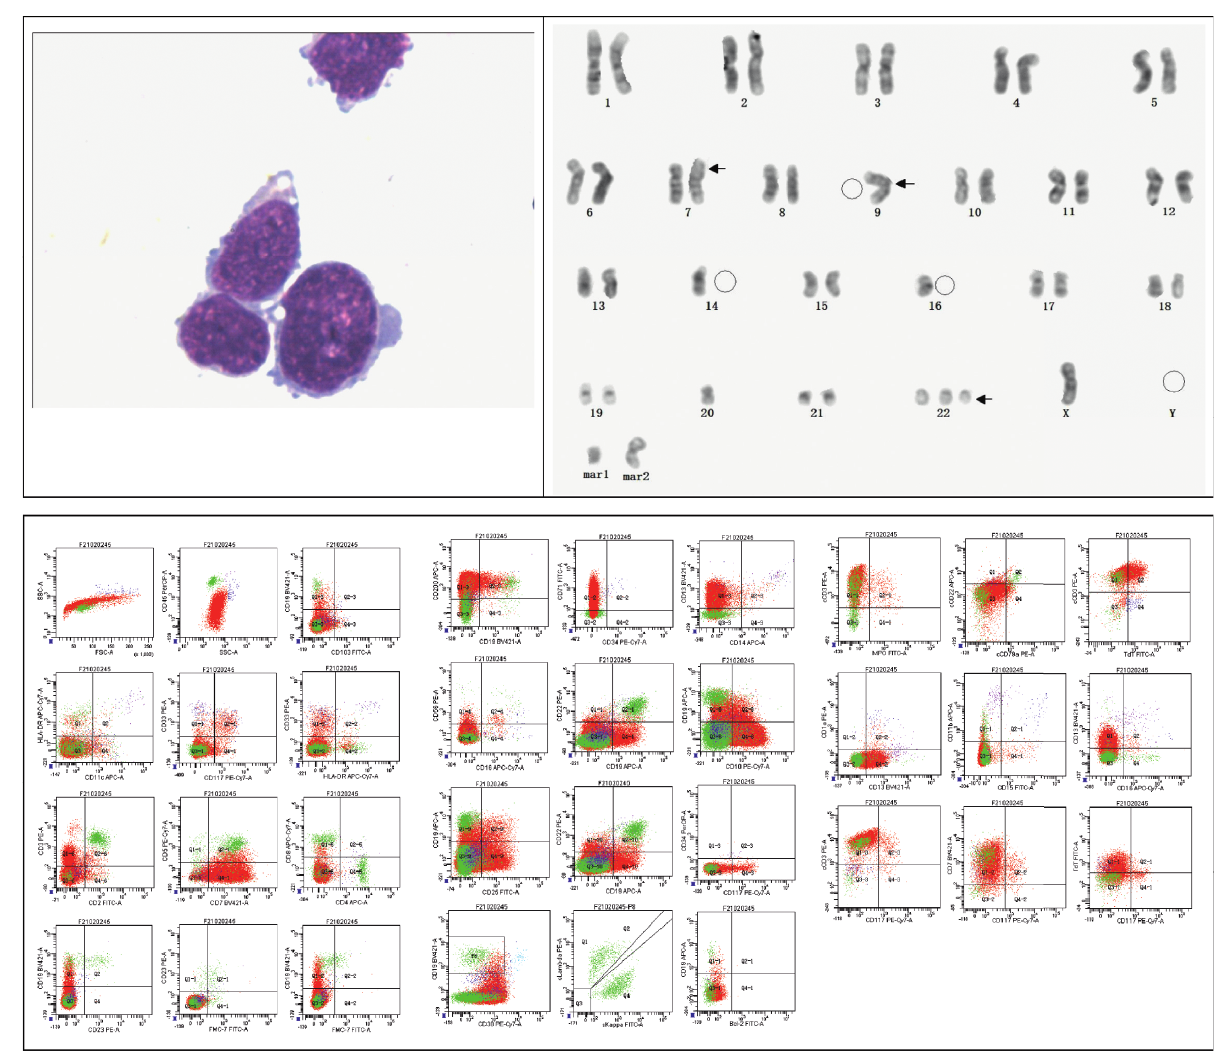
Figure 3: Results of pleural effusion sample. Table 1: Results of whole exome sequencing.